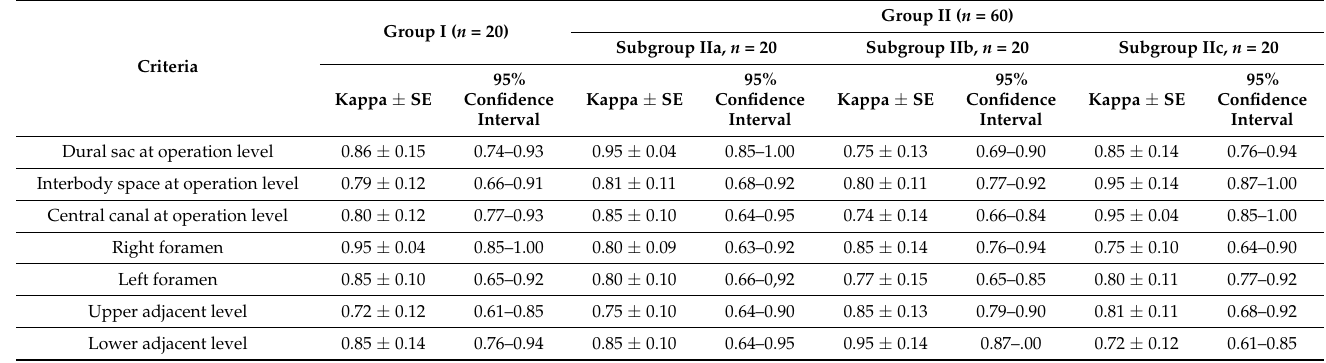
Table 2. Interobserver agreement of Jarvik 2000 [12] scores.